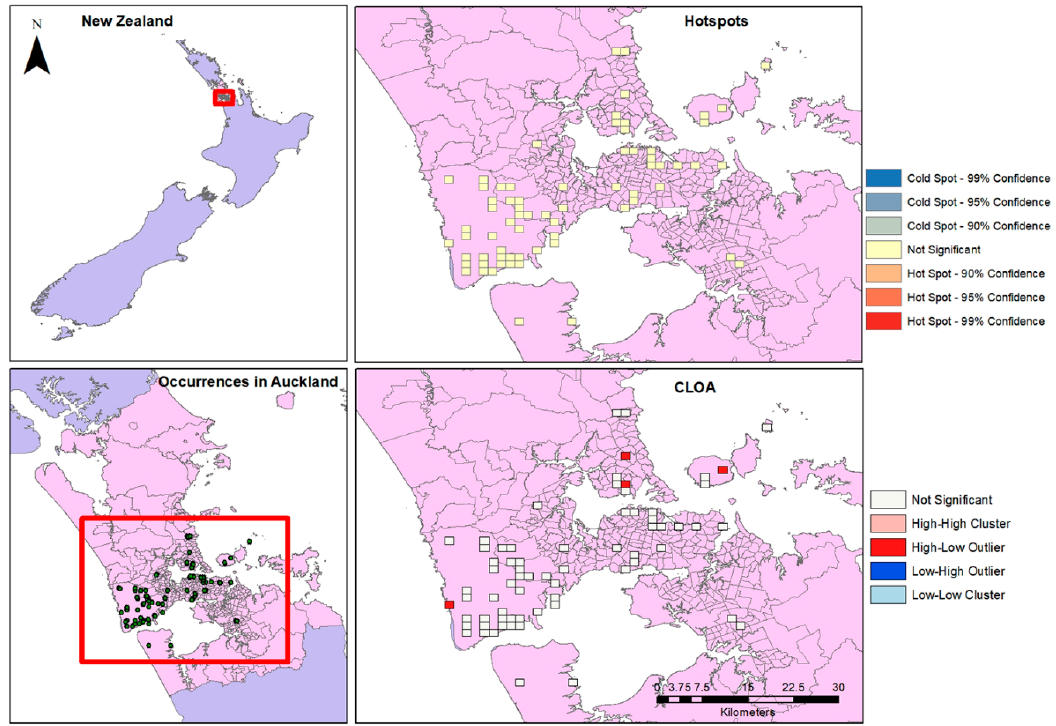
Figure 3. Occurrences, Hotspots and CLOA maps for Auckland.